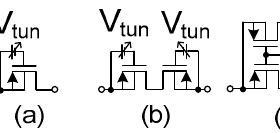
Figure 3. Tunable pseudo-resistors. ( a ) Single voltage-tuned PMOS device. ( b ) Series voltage-tuned topology. ( c ) Current-tuned topology.